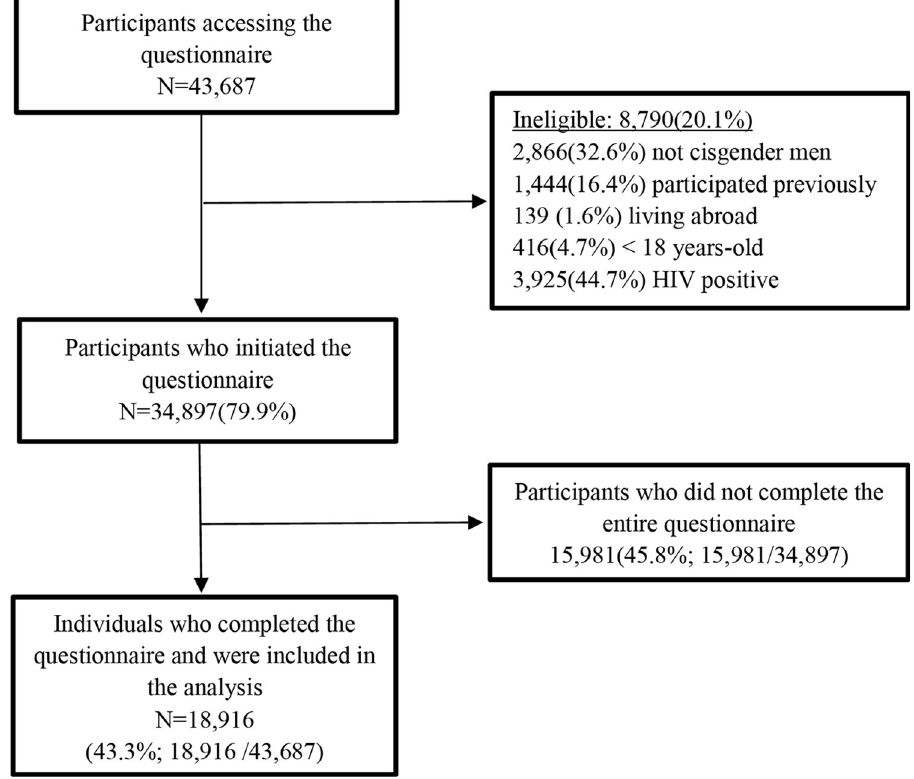
Fig 2. Study flow-chart. Brazil, Mexico, and Peru,